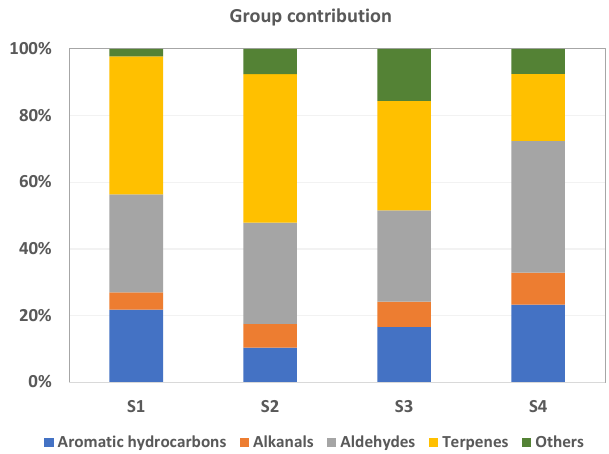
Figure 3. Chemical group distributions among the schools . Table 1. Comparison of VOC compositions ( μ g/m 3 ) among the studies on indoor air quality of childcare centers and pri- mary schools.